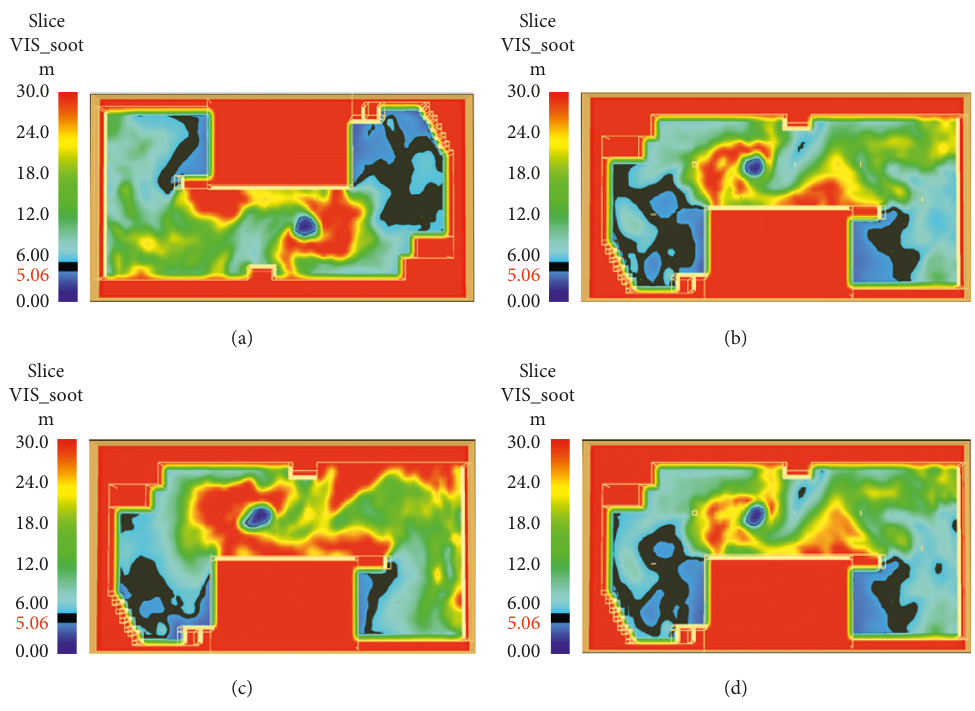
Figure 2: Critical time of fire hazard for scenario A. (a) A00, (b) A01, (c) A10, and (d)